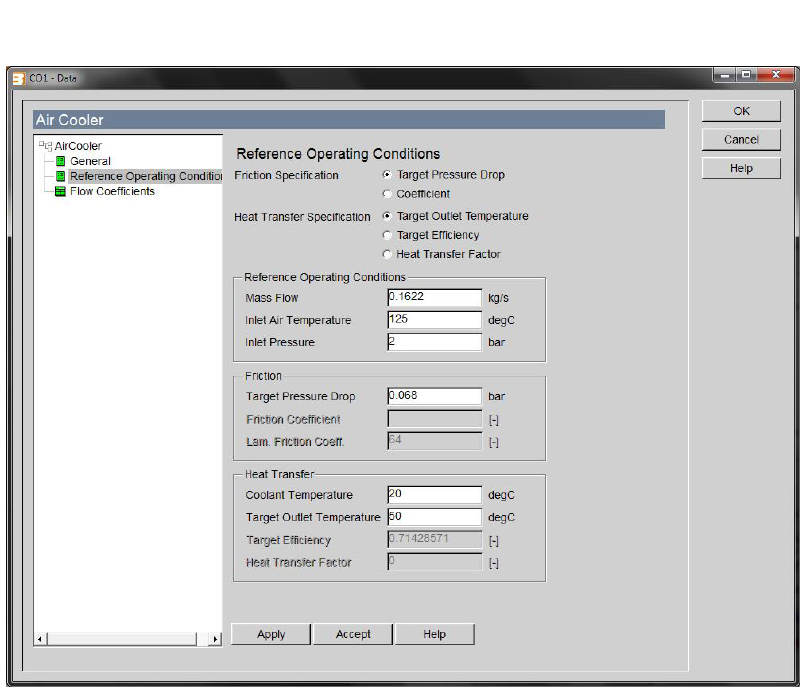
Figure 7. Intercooler configuration.